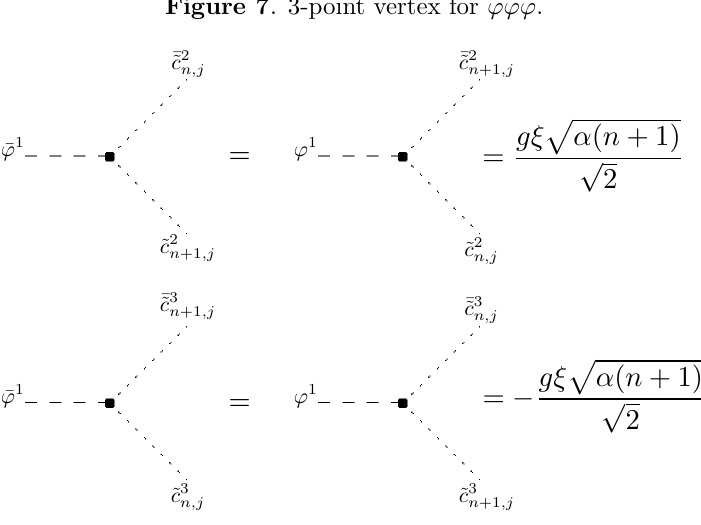
Figure 7 . 3-point vertex for ϕϕϕ .